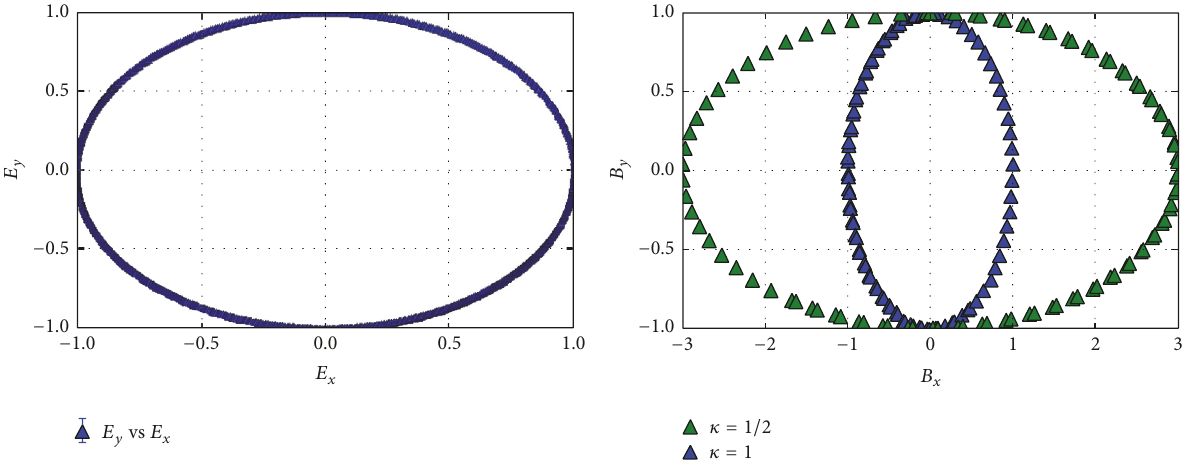
Figure 4: (Color online) effect of the 𝜅 on the elliptical polarization of the magnetic field, for 𝜅 = 1 and 𝜅 = 1/2